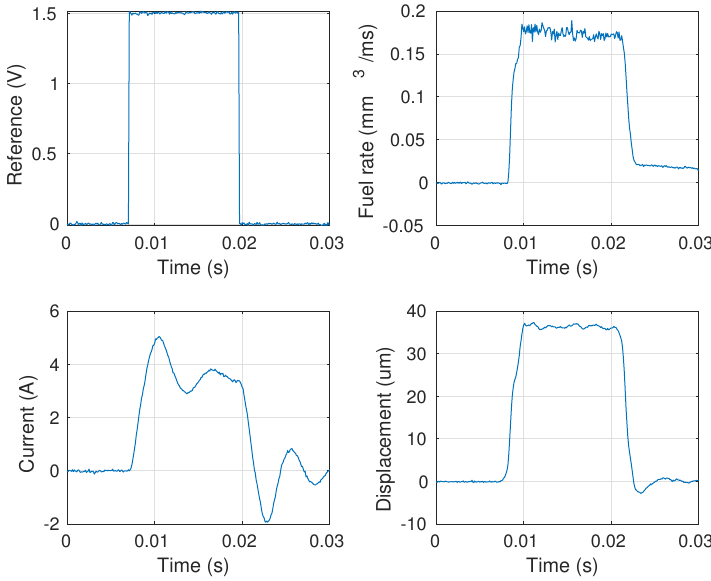
Figure 6. Measured signals with squared reference with t inj = 12 ms and P inj = 40